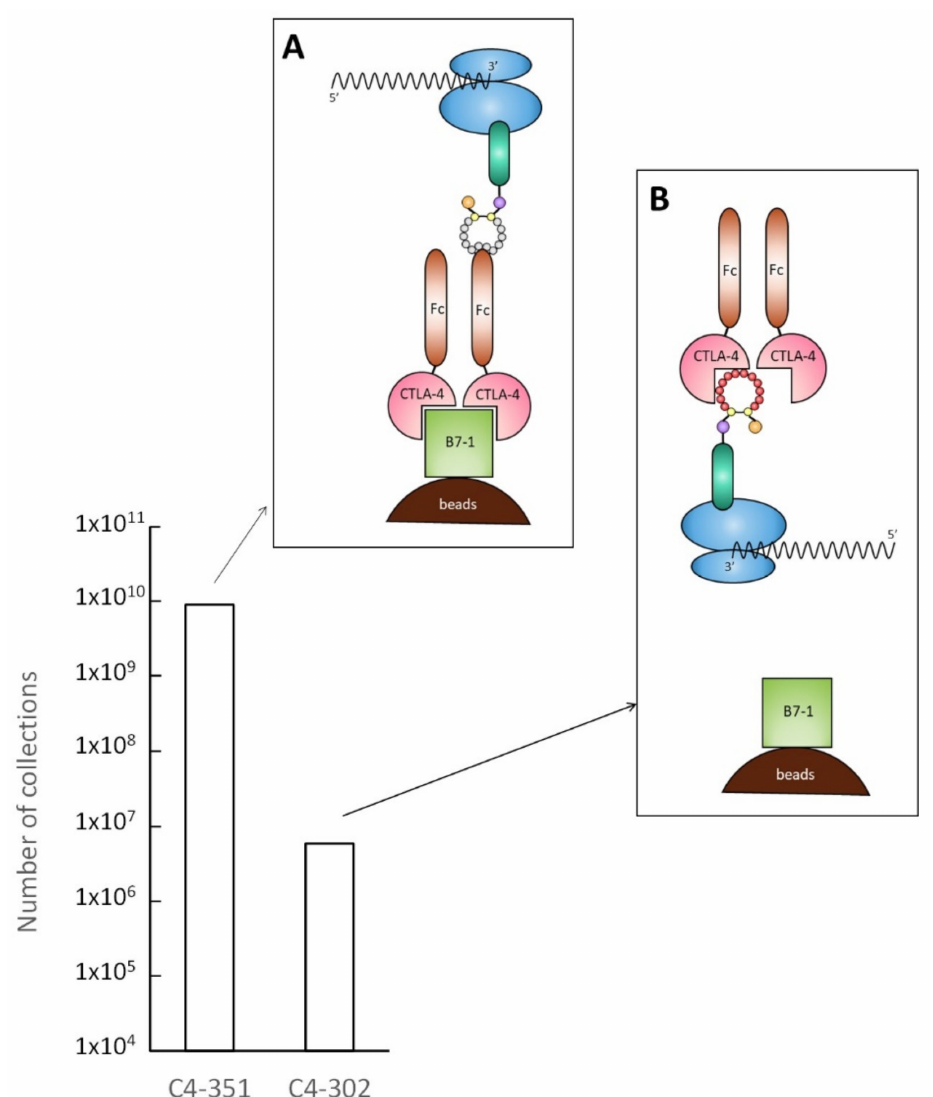
Figure 3. Inhibition of interaction between CTLA-4 and B7-1 by C4-302. Inhibitory activity of C4-302 was examined. C4-351, which was found to bind to Fc region of CTLA-4, was used as negative control. After mixing mRNA–ribosome–peptide complex of each clone with CTLA-4, B7-1 immobilized on streptavidin magnetic beads via biotin was added to the mixture. ( A ) Because C4-351 bound to the Fc region of CTLA-4, mRNA was collected at nearly 10 10 . ( B ) In C4-302, mRNA collection was reduced considerably to just under 10 7 . This finding suggests that the C4-302 mRNA–ribosome–peptide complex inhibited the interaction of CTLA-4 with